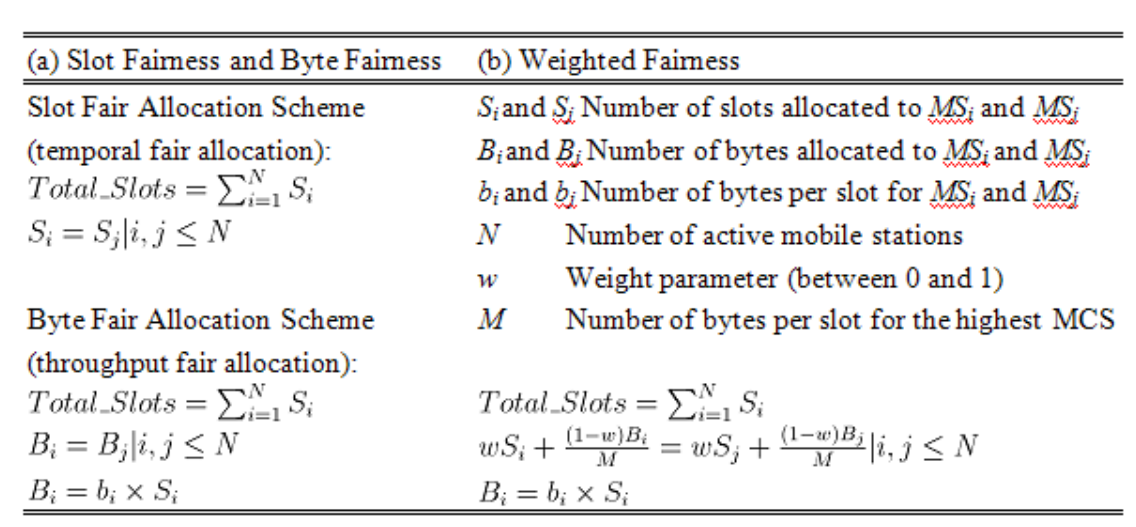
Figure 3. Fairness Definitions. (a) Slot Fair Allocation and Byte Fair Allocation; (b) Weighted Fair Allocation